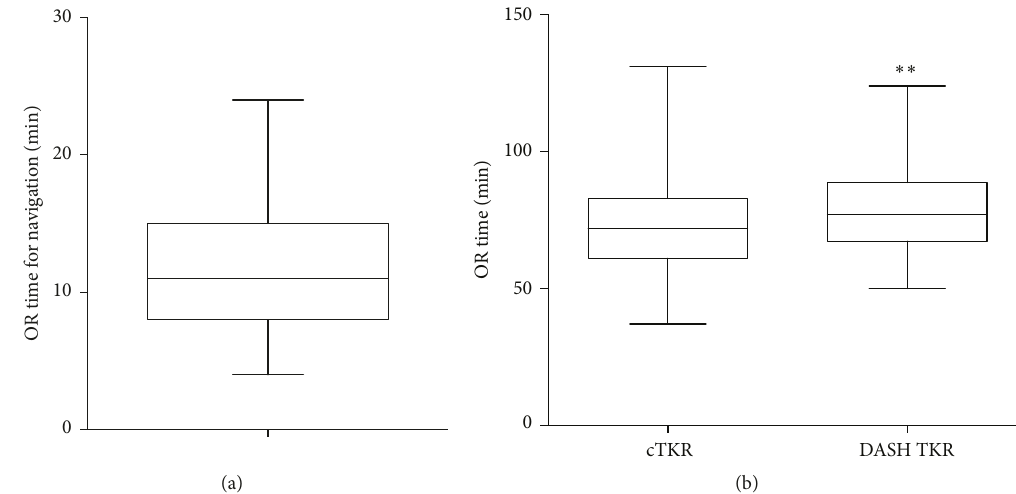
Figure 5: (a) Expenditure of time for all coronal bone resections and measurements of the navigation system, presented as boxplot. (b) OR time for DASH TKR ( 𝑛 = 144 ) and conventional TKR (cTKR; 𝑛 = 125 ), shown as mean ± SD. ∗∗ 𝑝 < 0.01